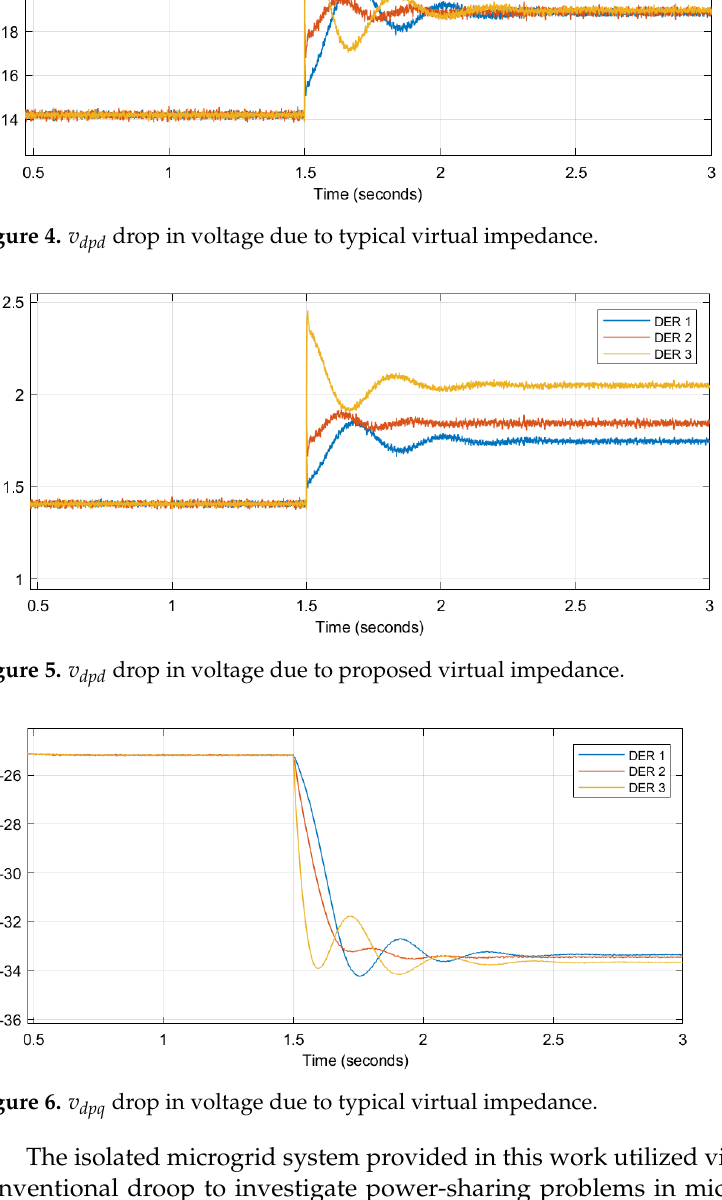
Figure 7. v dpq drop in voltage due to proposed virtual impedance.